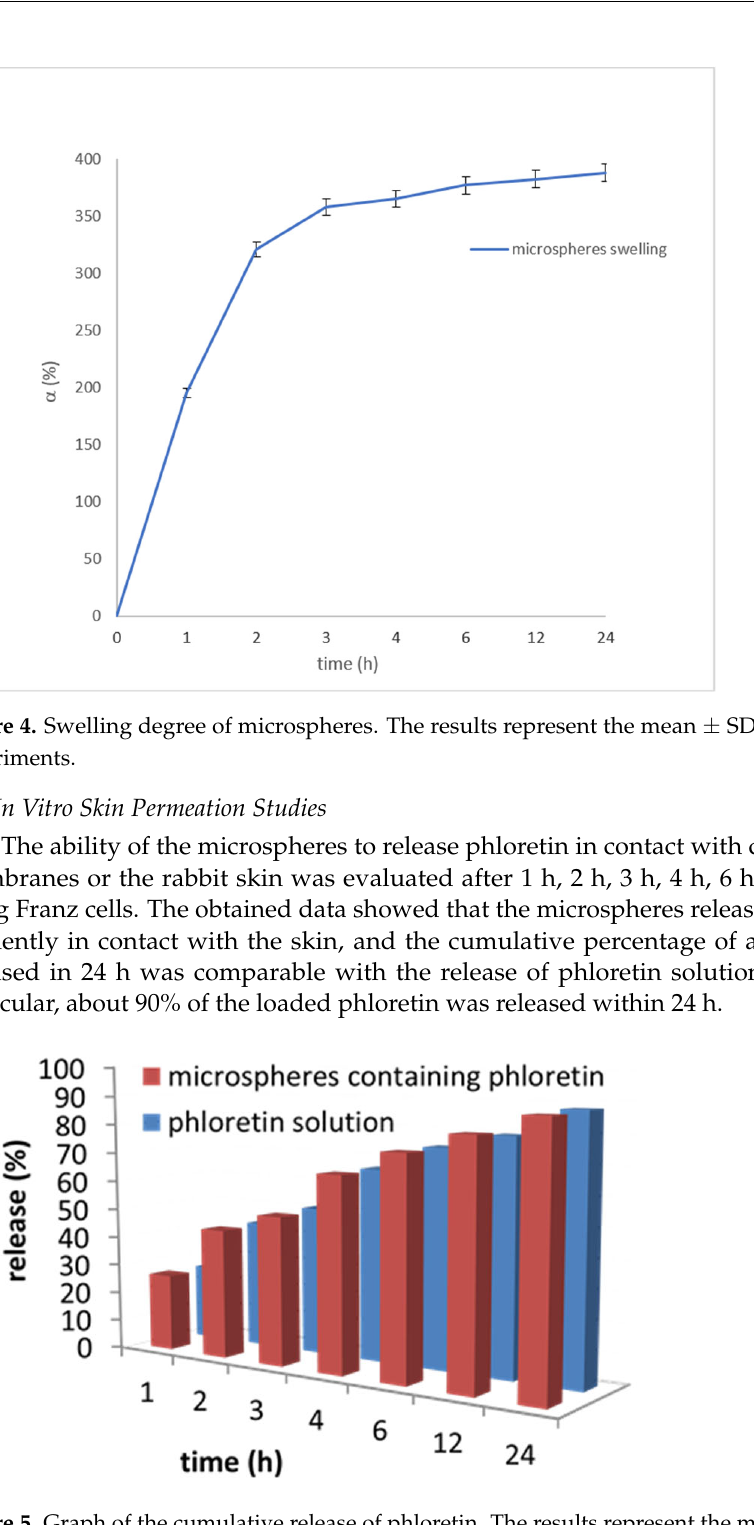
Figure 5. Graph of the cumulative release of phloretin. The results represent the mean ± SD of three separate experiments. Signi fi cance was evaluated by the unpaired t -test.